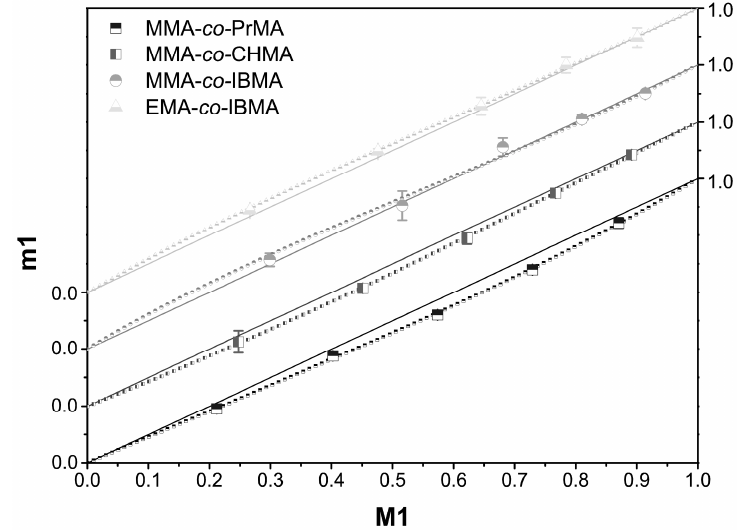
Figure 3. Axes adapted copolymerization diagram for the nearly truly random copolymers MMA- co -PrMA (half-filled squares top), MMA- co -CHMA (half-filled squares left), and EMA- co -IBMA (half-filled triangle bottom), and for the azeotropic copolymer MMA- co -IBMA (half-filled circle top, azeotropic point 66.6 mol % MMA), each with the Mayo-Lewis plot (dots).